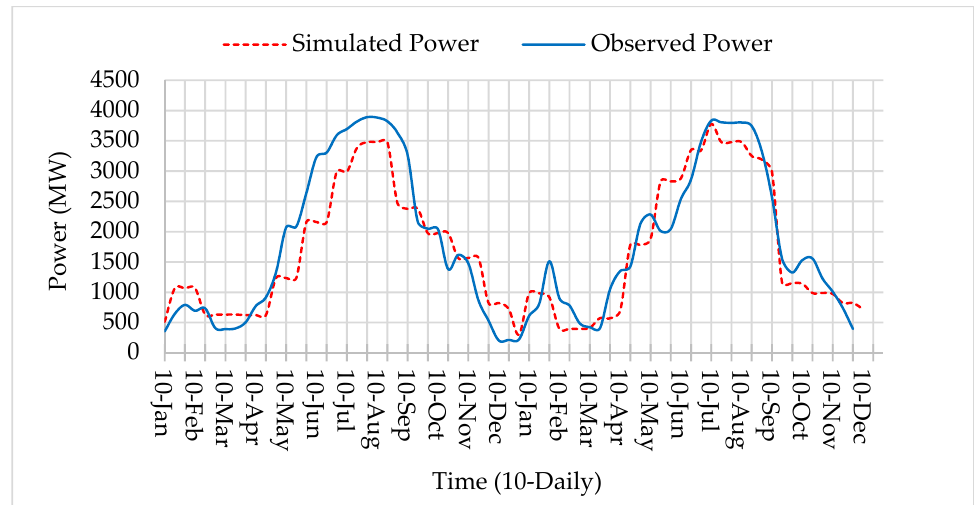
Figure 23. Validation of the Model for Irrigation Releases (2008 and 2009).